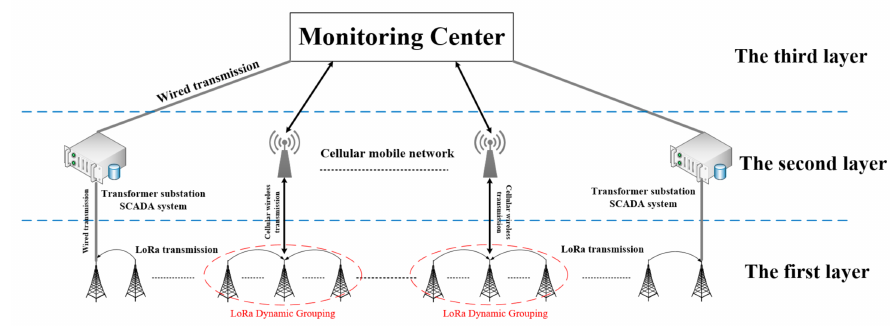
Figure 2. Monitoring network structure of the transmission line in a mountainous